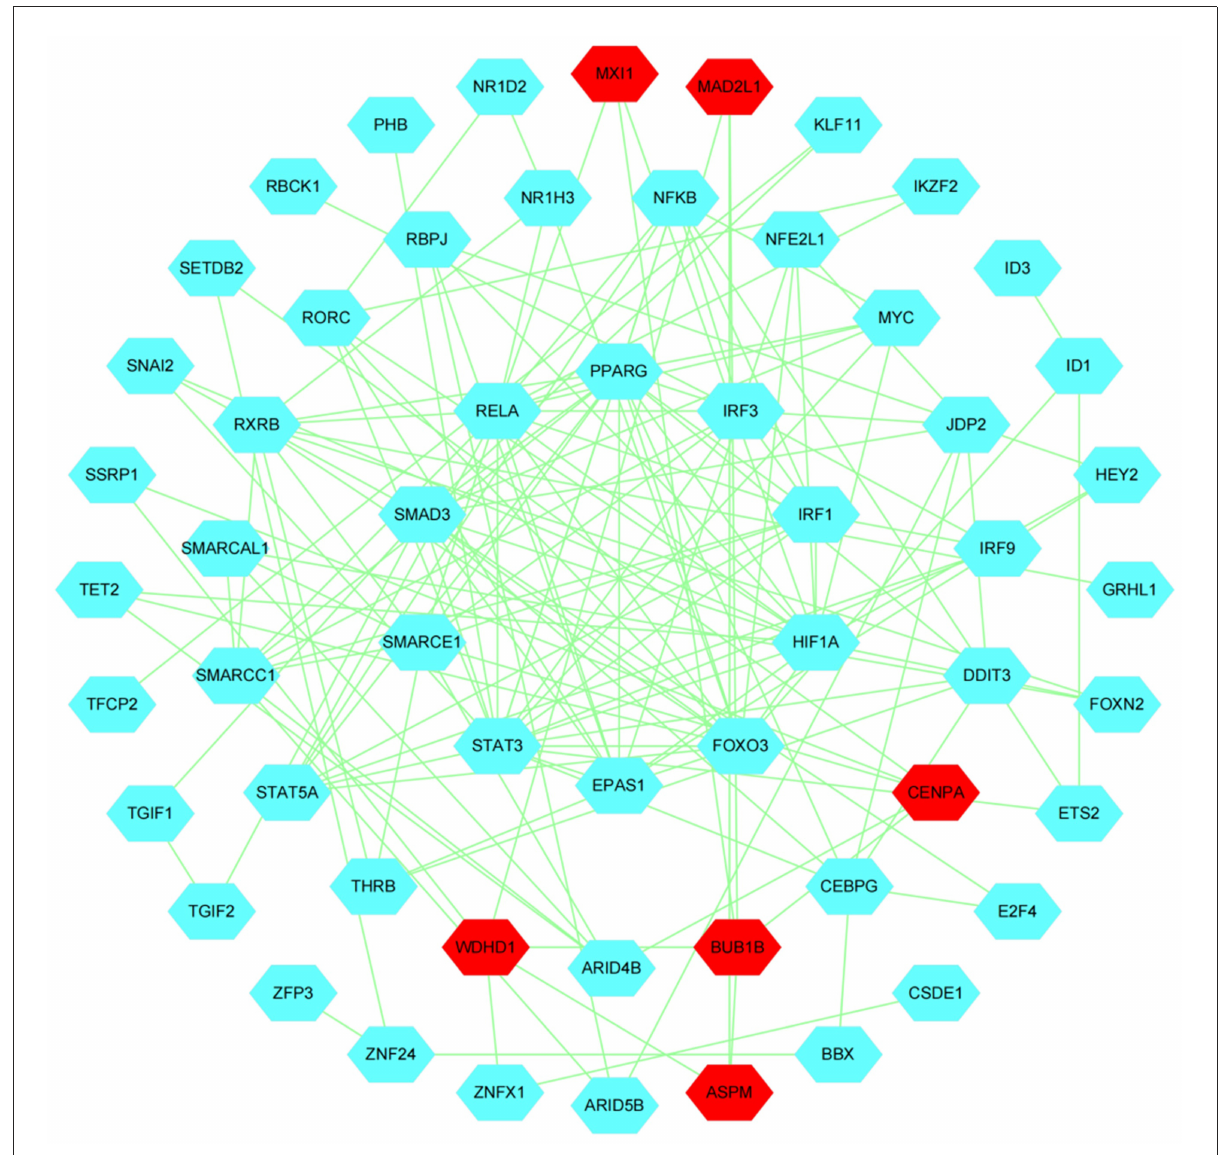
FIGURE13 Construction of Hub genes and TFs regulation networks about follicular development pathway by Cytoscape software. The Red and cyan hexagons represent identified hub genes involved in the network.